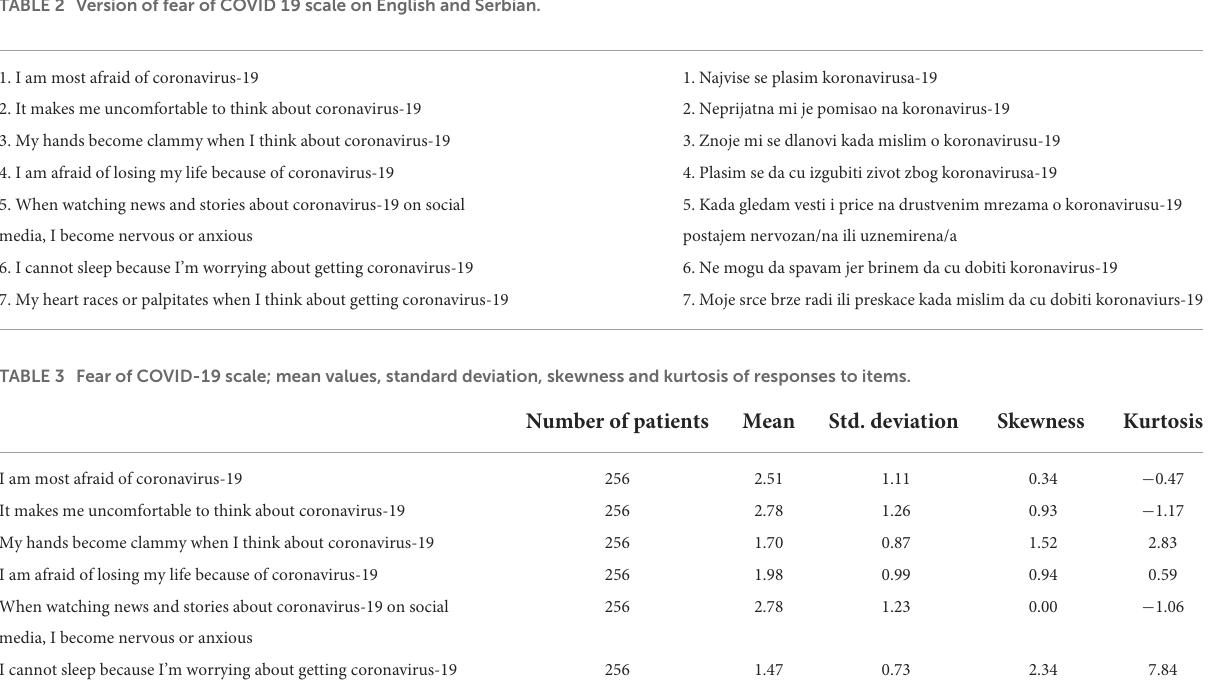
TABLE 2 Version of fear of COVID 19 scale on English and Serbian.